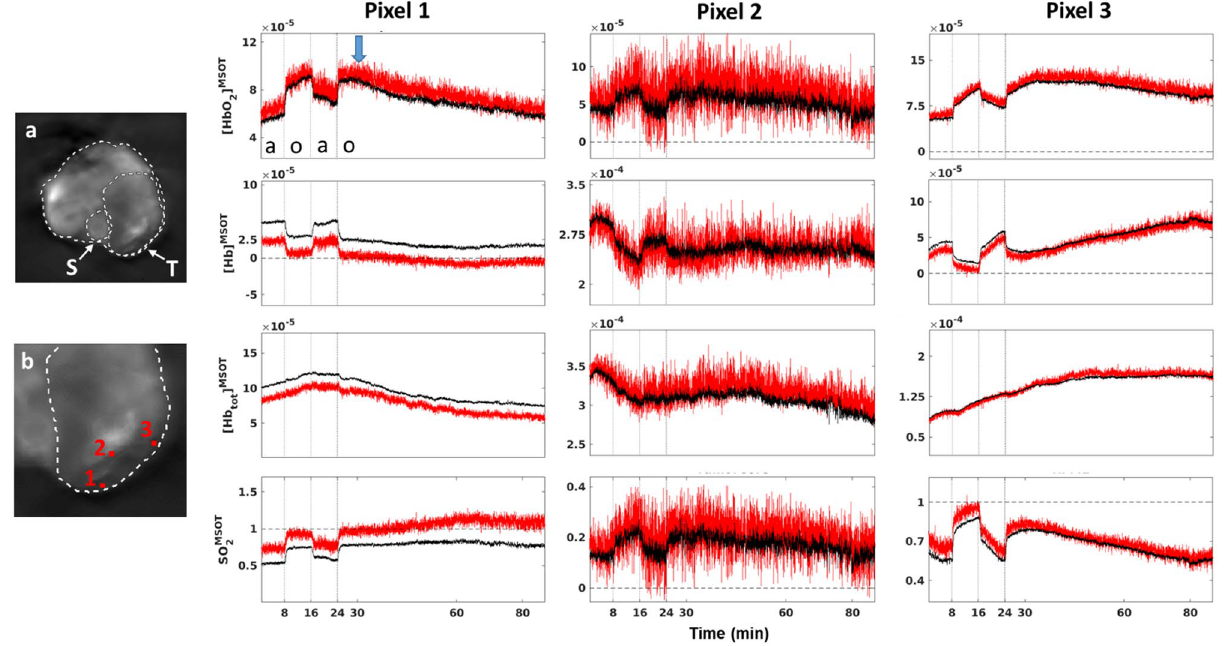
Figure 6. Comparison of different processing approaches implemented using the MSOT-RAFT for analysis of Dataset A. ( a ) Mean cross-sectional [Hb tot ] MSOT image. S: Spine, T: Tumor. ( b ) Expanded view of tumor periphery, with pixels of interest highlighted; relative size of highlighted squares is larger than a single pixel to improve visibility. The unconstrained approach (red) is substantially noisier and regularly incurs non-physical negative values in the low-signal outer tumor (Pixel 1, [Hb] MSOT ), which result in spurious values exceeding 1 for downstream SO 2 MSOT calculation (Pixel 1, SO 2 MSOT ). Poor SNR as seen in Pixel 2 is managed with an αβ filter (black), making the transitions between gases much more conspicuous. The αβ filter preserves the dynamical structure of each pixel as well, as seen in the transitions of Pixel 3. Figure created using a combination of MATLAB and Microsoft PowerPoint.